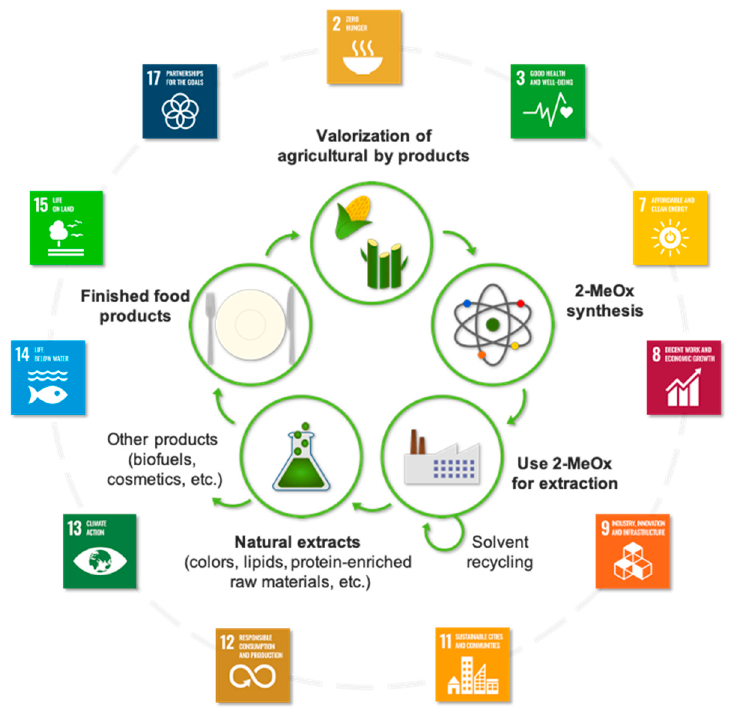
Figure 12. 2-MeOx chain value and its potential positive contributions to sustainable development goals (SDGs).